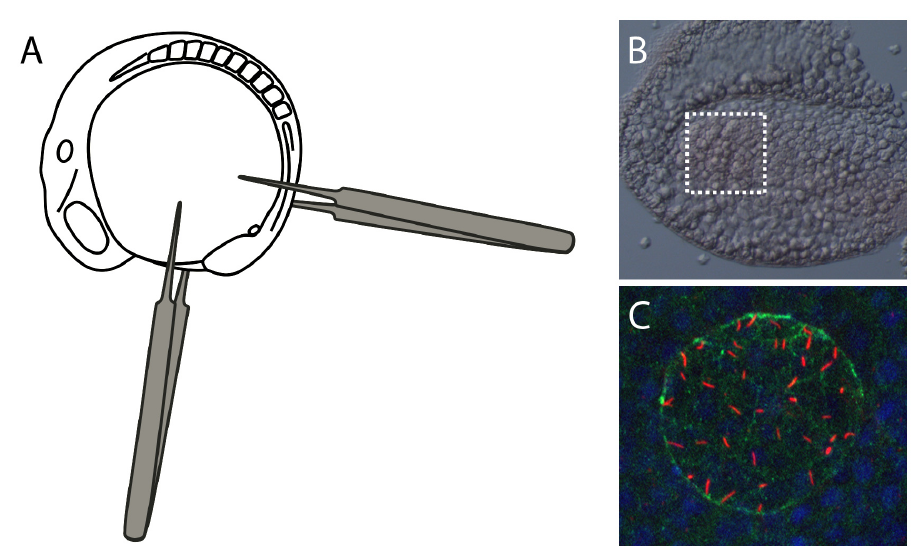
Figure 3. Mounting samples for visualization of Kupffer’s vesicle. Schematic showing a 10 somite stage zebrafish embryo ( A ). Forceps can be used as depicted to separate the tail tip from the rest of the embryo. Excess yolk is then removed, and the tail tip mounted flat on to a microscope slide. ( B ) Bright field image overlaid with fluorescence image of flat-mounted tail tip. The white box depicts the location of Kupffer’s vesicle. Fluorescence from acetylated- α tubulin (red) can be seen within this region. ( C ) Confocal image of Kupffer’s vesicle, visualised using acetylated- α tubulin (red), aPKC (green) and DAPI